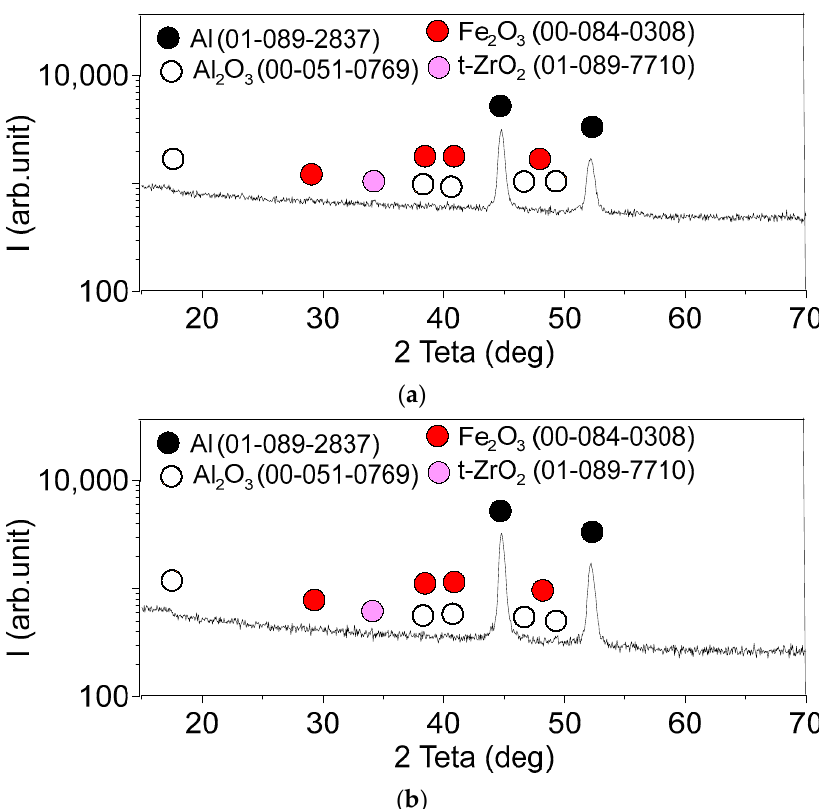
Figure 20. Coefficient of friction vs. time dependencies of FSP-ed RPPs/AA5056 composite: ( a ) FSP- ed RPPs/AA5056 composite after 4 passes; ( b ) FSP-ed RPPs/AA5056 composite after 8 passes. The GIAXRD from the worn surfaces of the four-pass (Figure 21a) and eight-pass (Figure 21b) composites allowed for identifying the presence of iron oxide Fe 2 O 3 , in addi- tion to the phases formed during the FSP (Figure 15a,b).